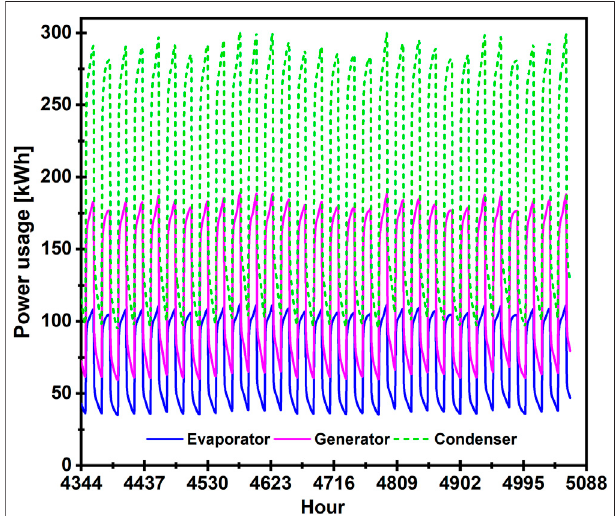
FIGURE 8 | Chilled water mass fl ow rate variations.